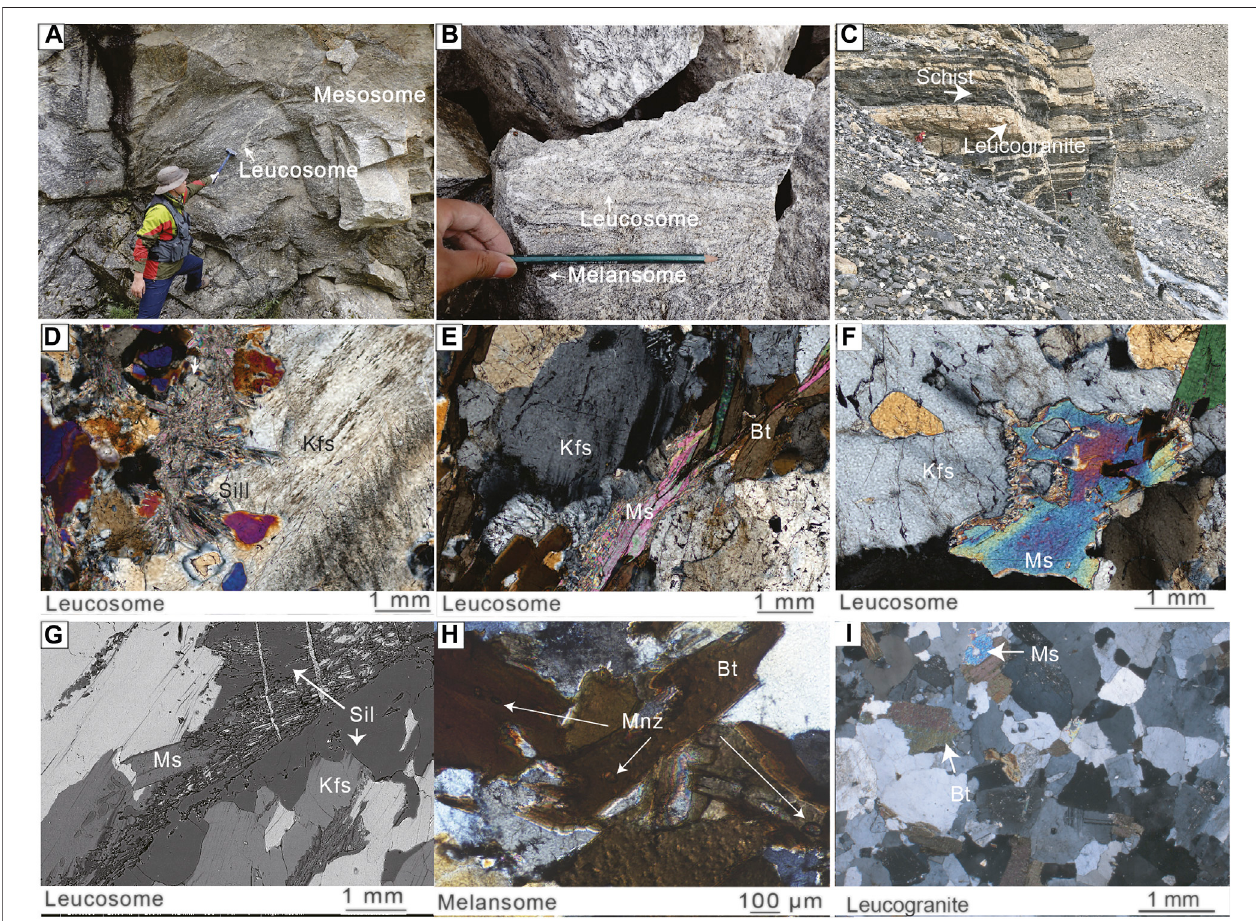
FIGURE 3 | (A and B) Representative outcrop photographs of the leucosome, (C) and leucogranite in the Nyalam region. (D and F) Microphotographs of leucosome showing the muscovite dehydration melting reactions de fi ned by Ms relicts adjacent to the Kfs and Sil. (G) Back-scattered electron image of leucosome showing the muscovite dehydration melting reactions. (H) Monazite were wrapped in the biotite of the melansome. (I) Microphotographs of the leucogranite..